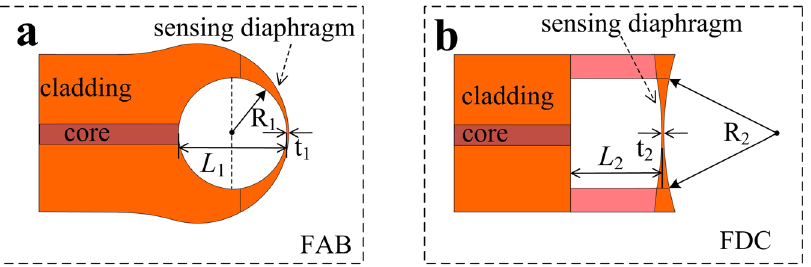
Figure 4. Schematic diagrams illustrating the geometric parameters affecting the gas pressure sensitivity. ( a ) An FPI-based gas pressure sensor employing an FAB. ( b ) An FPI-based gas pressure sensor employing an